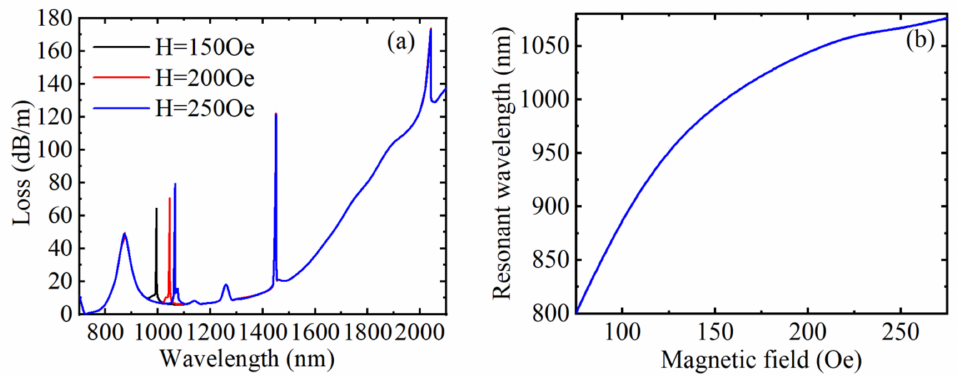
Figure 4. When n = 1.41, T = 20 ◦ C, and V = 30 V, under different magnetic field strengths, ( a ) the loss spectrum of the core guide mode, ( b ) the variation relationship between the resonance wavelength corresponding to peak 2 and the magnetic field